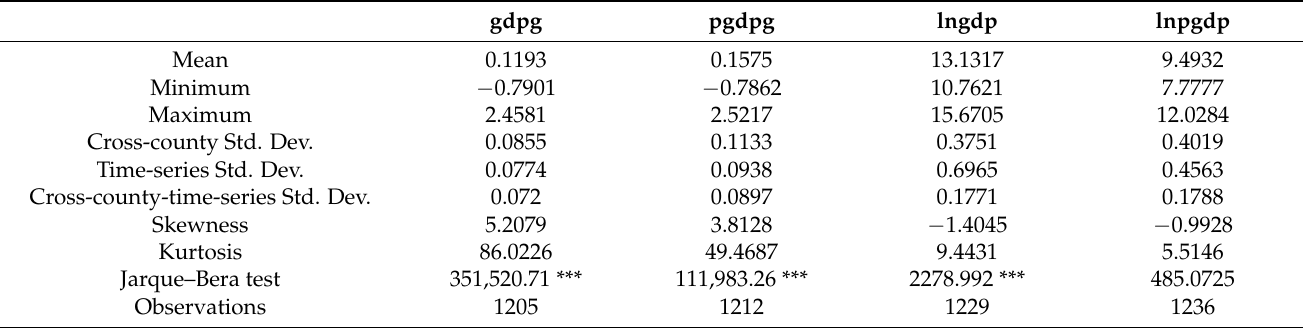
Table 1. Descriptive statistics of the economic performance indicators.